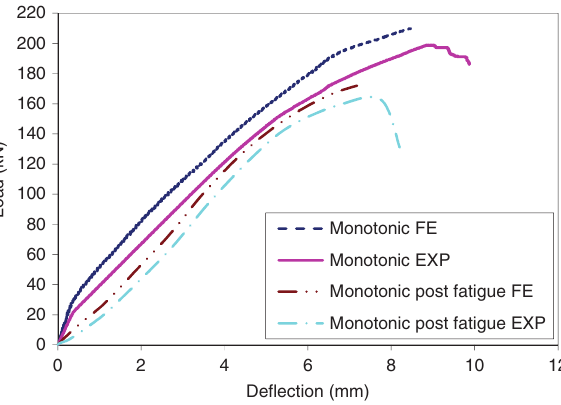
Figure 17: Comparison of monotonic and post-fatigue monotonic load-deflection curves of CFRP-retrofitted RC specimens obtained by FE and experimental